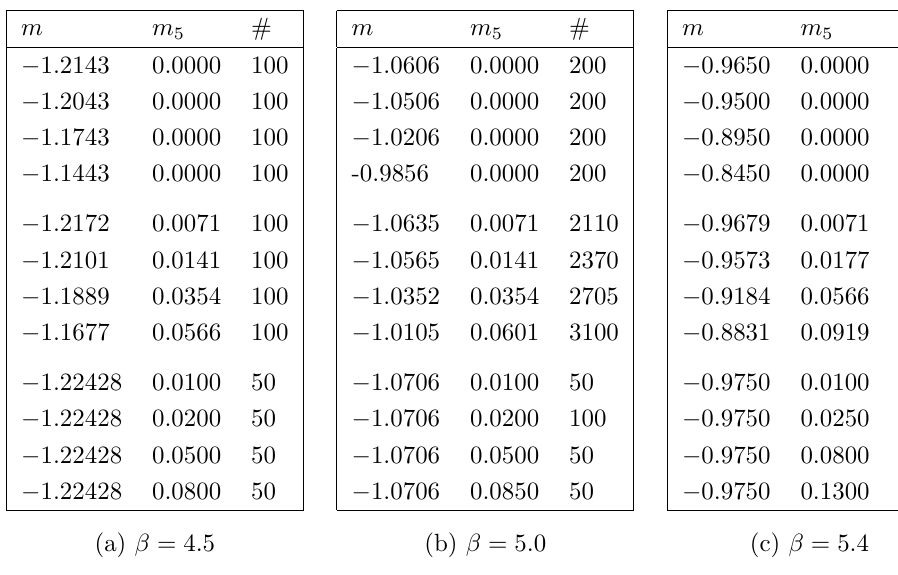
Table 6 . Overview of the parameter sets. Three different lattice couplings β , two different lattice volumes V = L 3 × T and two different combinations of ( r, r 5 ) are used within this paper. For each setting, the mass parameter m crit of the critical point as well as the ranges of m and m 5 are listed.